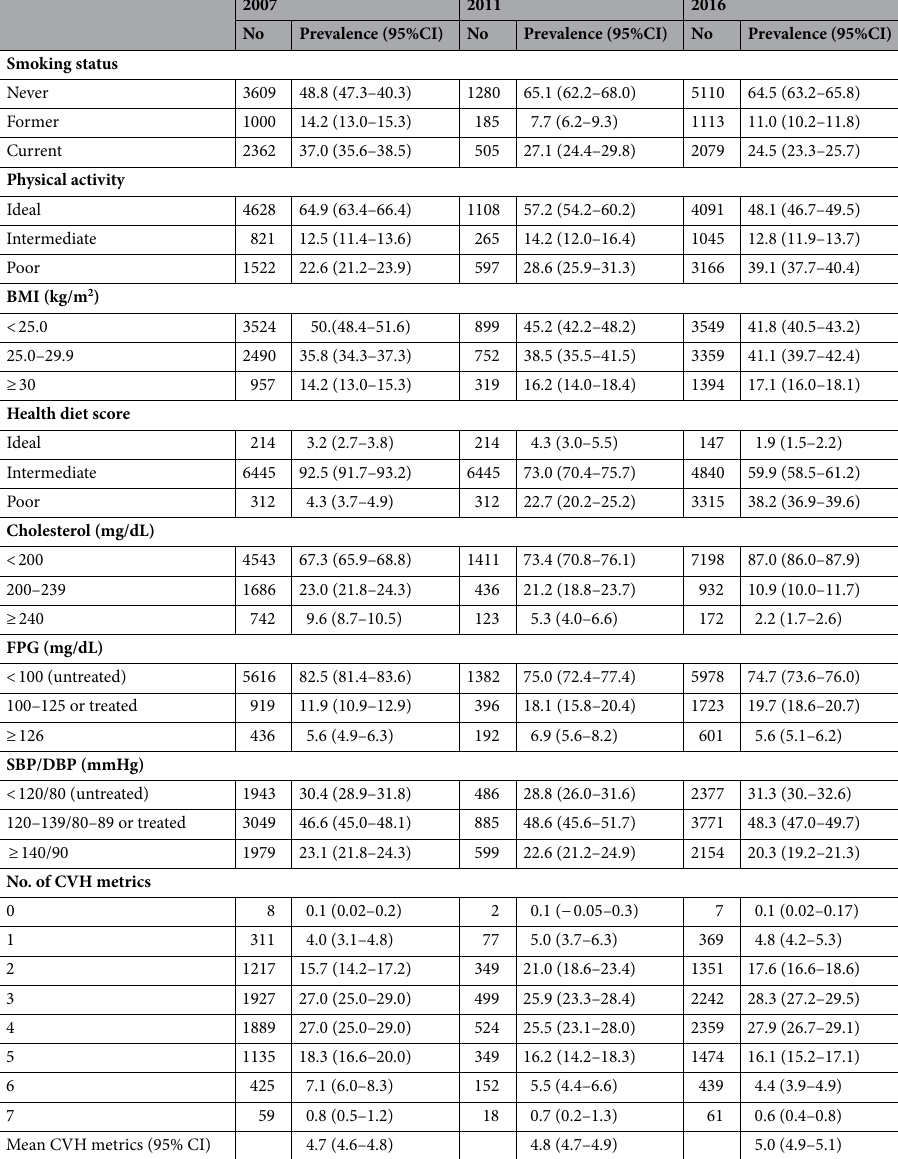
Table 5. Prevalence of cardiovascular health metrics in among males in STEPS 2007, 2011, 2016. Data from each survey is weighted for age, sex, area of residence, on the basis of Iranian census population 2011. STEPS, STEPwise approach to surveillance; BMI, body mass index; TC, total cholesterol; FPG, fasting plasma glucose; SBP, systolic blood pressure; DBP, diastolic blood pressure; ICVH, Ideal cardiovascular health metrics. SI conversion factors: to convert total cholesterol values to mmol/L, multiply by 0.0259; to convert glucose values to mmol/L, multiply by